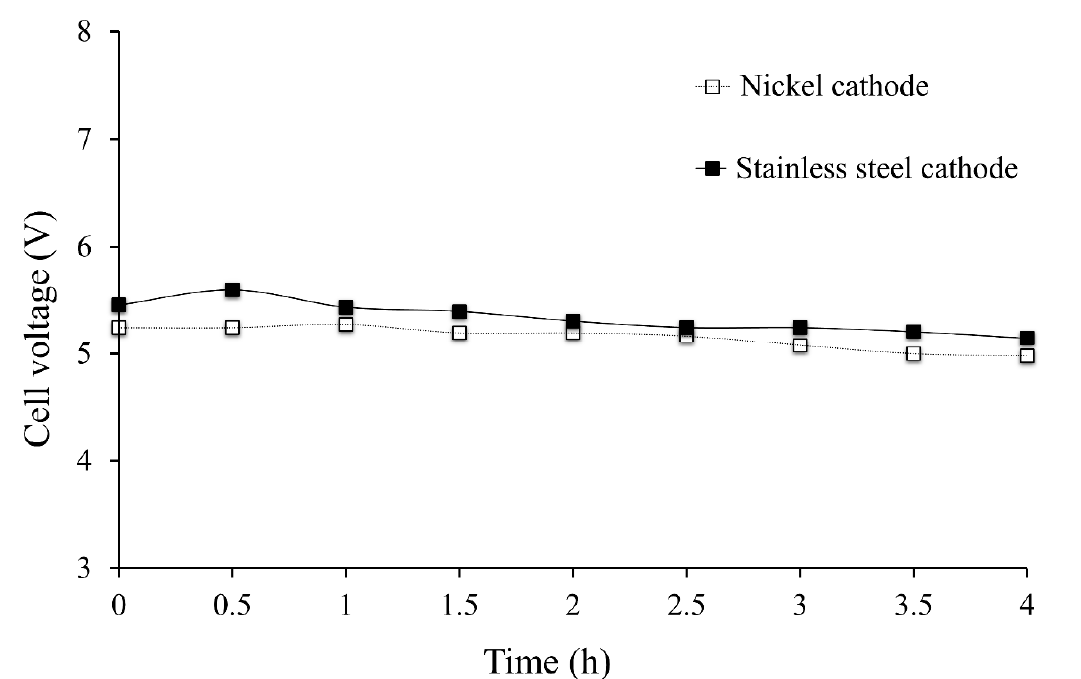
Figure 10. Cell voltage vs. time of operation by type of cathode at 2400 A / m 2 .